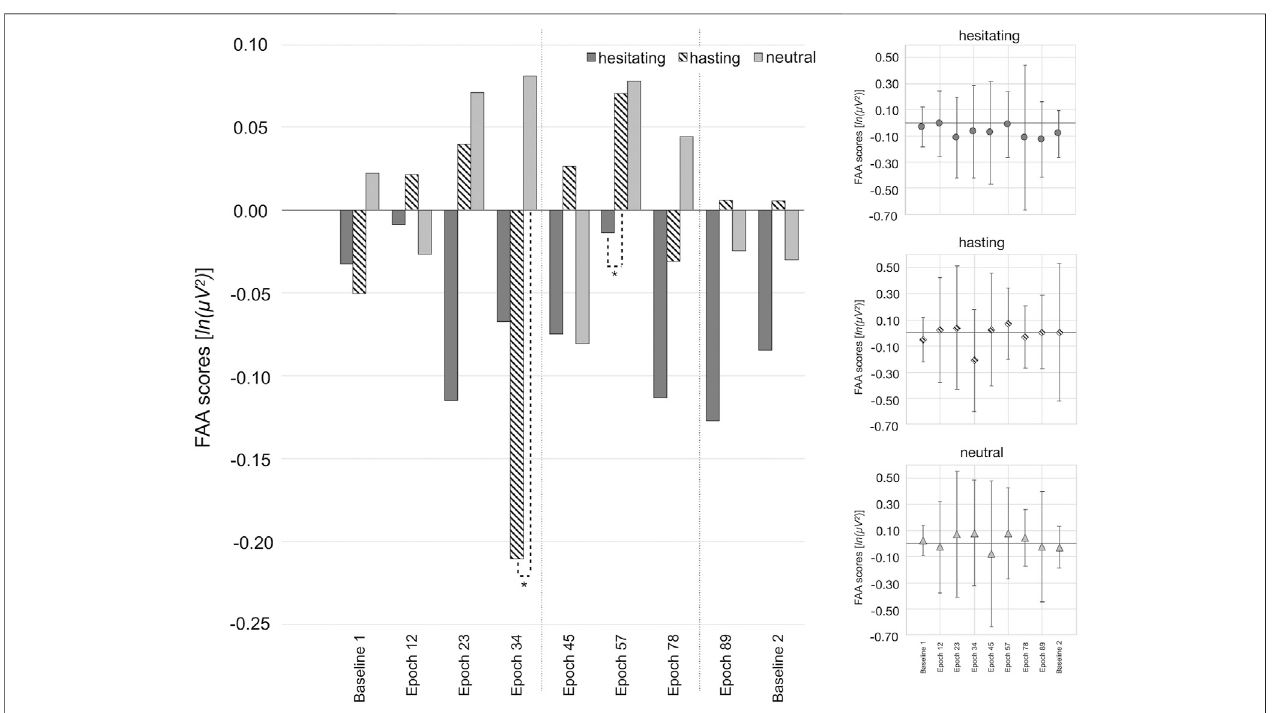
FIGURE 3| FAA scores[ln (µV 2 )]per subgroup and epoch ofthe caveexploration. Signi fi cantdifferences between groups are marked (* p < 0.05; ** p ≤ 0.01, *** p ≤ 0.001). Positive FAA scores indicate relatively greater right frontal cortical activity, whereas negative FAA scores indicate relatively greater left frontal cortical activity. The standard deviations from group mean are depicted as error bars in separate panels for increased visibility. The area between both dotted grey lines indicate the epochs during which the creature (werewolf/sheep) was visible.